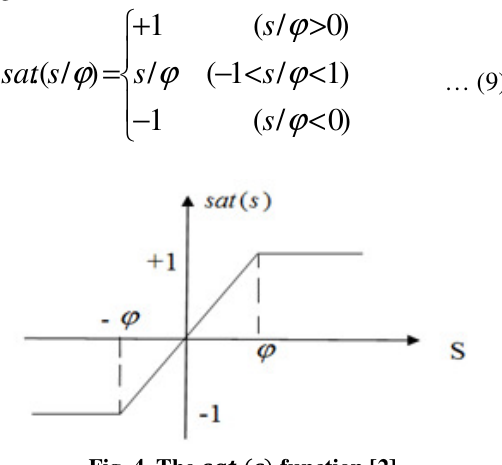
Fig. 4. The /01 (cid:11)/(cid:13) function [2].